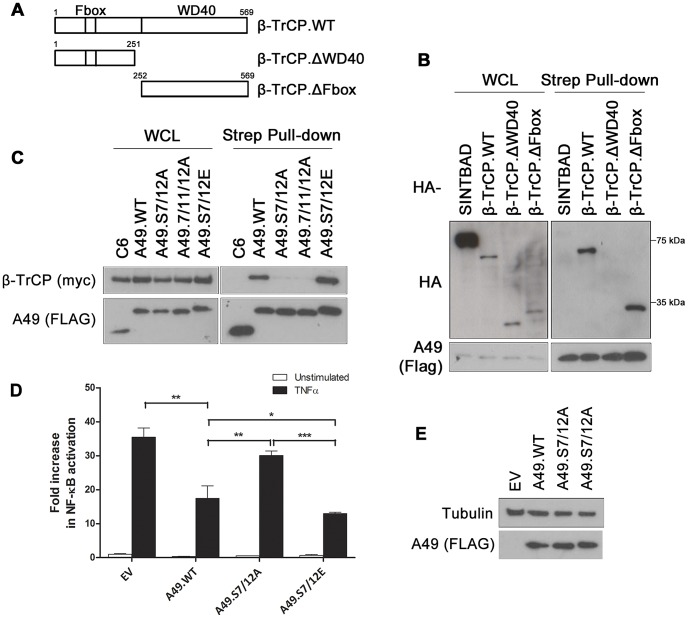
A49 binding to β-TrCP WD40 domain requires its N-terminal region.(A) Domains of β-TrCP and truncations generated. β-TrCP.ΔWD40 (1–250), β-TrCP.ΔF box (251–569). (B) HeLa cells were cotransfected with nTAP-A49 together with HA-tagged WT β-TrCP, ΔWD40 β-TrCP, ΔF-box β-TrCP or SINTBAD. After 24 h cells were lysed in IP buffer and a streptavidin pull-down was performed. WCL (2.5%) of each sample was analysed. (C) HeLa cells were cotransfected with myc-tagged β-TrCP together with nTAP-tagged WT A49, S7/12A A49, 7/11/12A A49, S7/12E A49 or C6 as a negative control. After 24 h cells were lysed in IP buffer and a streptavidin pull-down was performed. A fraction (2.5%) of each whole cell lysate (WCL) was analysed. (D) HEK293T cells were transfected with an NF-κB luciferase reporter, a renilla luciferase reporter and 100 ng of either nTAP-tagged WT, S7/12A or S7/12E A49 plasmids, or empty vector (EV). After 24 h cells were stimulated for 6 h with 20 ng/ml TNFα and luciferase activity was measured. Data are presented as mean ± SD and show one representative experiment of at least three, each performed in triplicate. *p<0.05, **p<0.01 or ***p<0.001 comparing conditions pair-wise as indicated. (E) Lysates from TNFα-stimulated samples from the reporter gene assays were fractionated and immunoblotted for FLAG and tubulin. WCL (10%) of each sample was analysed. Data shown in (B–C) are one representative experiment of at least three showing indistinguishable results.